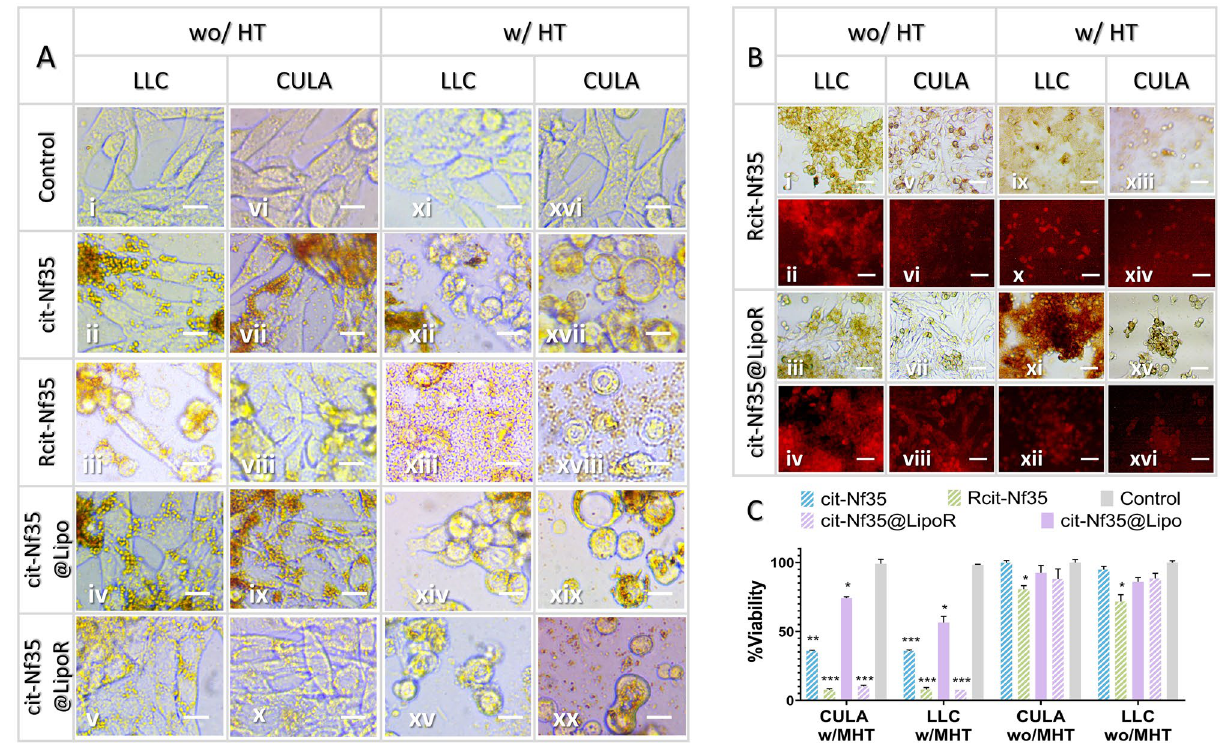
Figure 7. In vitro magnetic hyperthermia after-effects 24 h post treatment ( A ) Live optical microscopy ( B ) Optical fluorescent microscopy (all scale bars at 10 μm) after fixation ( C ) MTT viability assay (*0.01 < p < 0.05, **0.001 < p < 0.01, ***0.0001 < p <